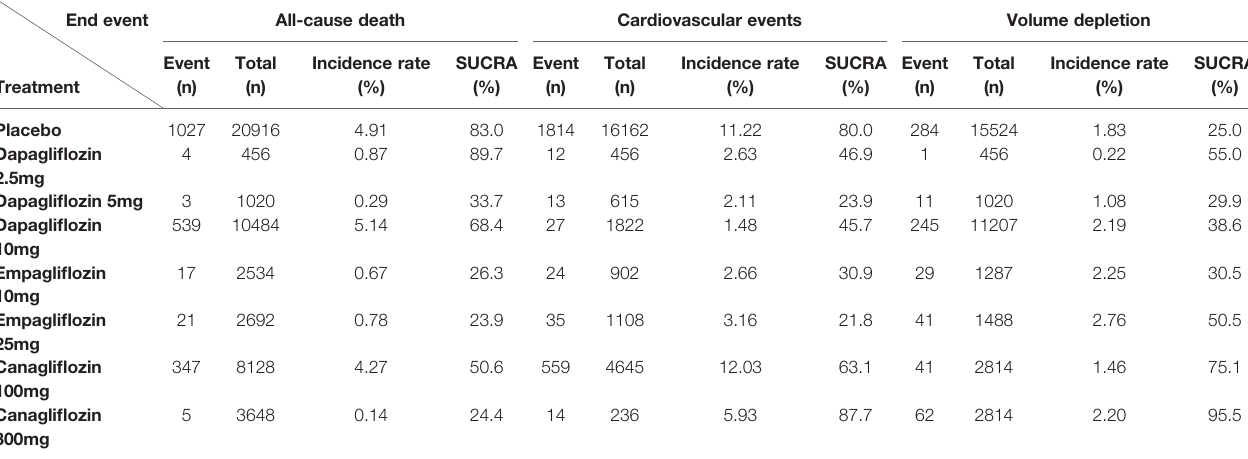
The graphs display the distribution of probabilities of treatment ranked from best toworst foreach outcome. The ranking indicates theprobability that the drug class is fi rst “ best, ” second “ best ” ,etc.Forexample,therankingsuggeststhatdapagli fl ozin2.5mgposedthehighestriskforincurringall-causedeath(worst),whileempagli fl ozin25mgincurredthelowestprobability of all-cause death